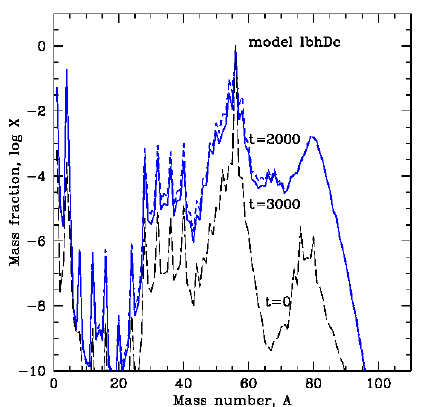
Figure 2. Volume integrated abundance distribution of elements synthesized in the accretion disk, based on the 2D simulation. Parameters: disk to BH mass ratio of M d / M BH = 0.25, BH spin a = 0.9. Abundances were calculated from the density, temperature, and electron fraction profiles, as evolved to the time t = 2000 M (solid line) and t = 3000 M (dashed line), while the long-dashed line shows the distribution at time t =